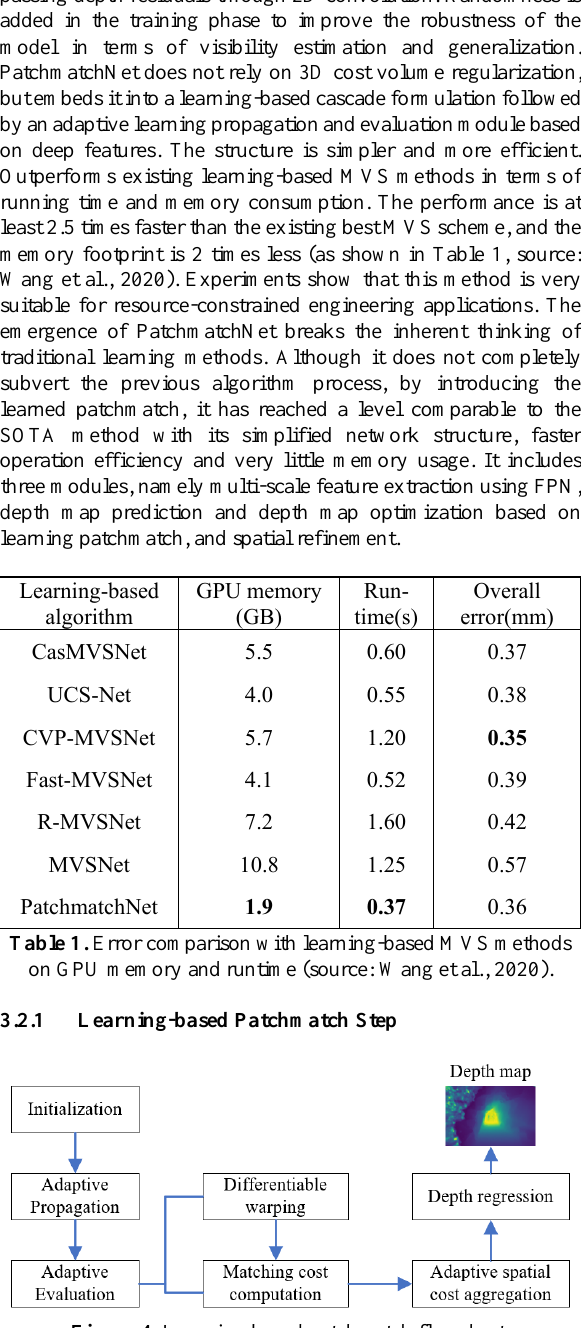
Figure 4. Learning-based patchmatch